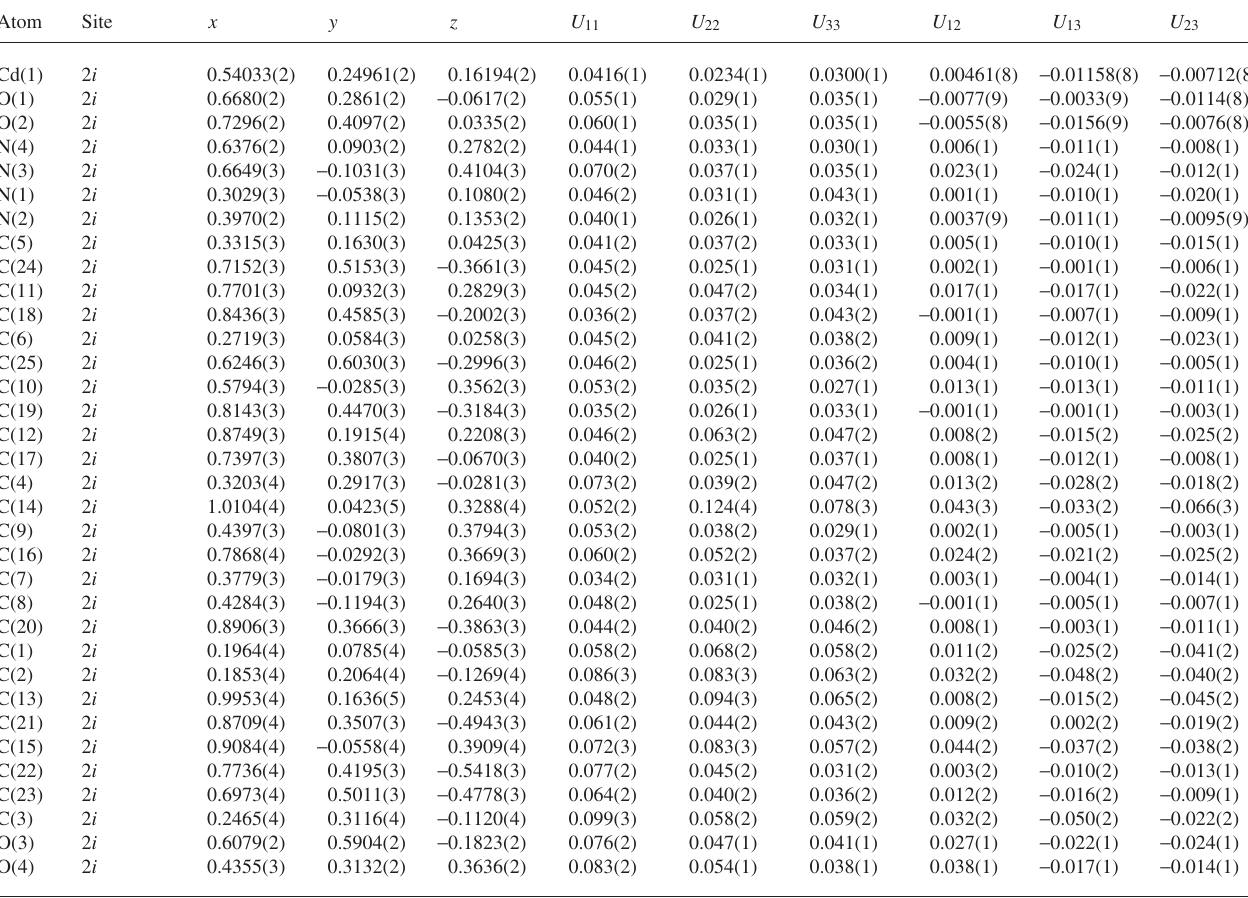
Table 3. Atomic coordinates and displacement parameters (in Å 2 )